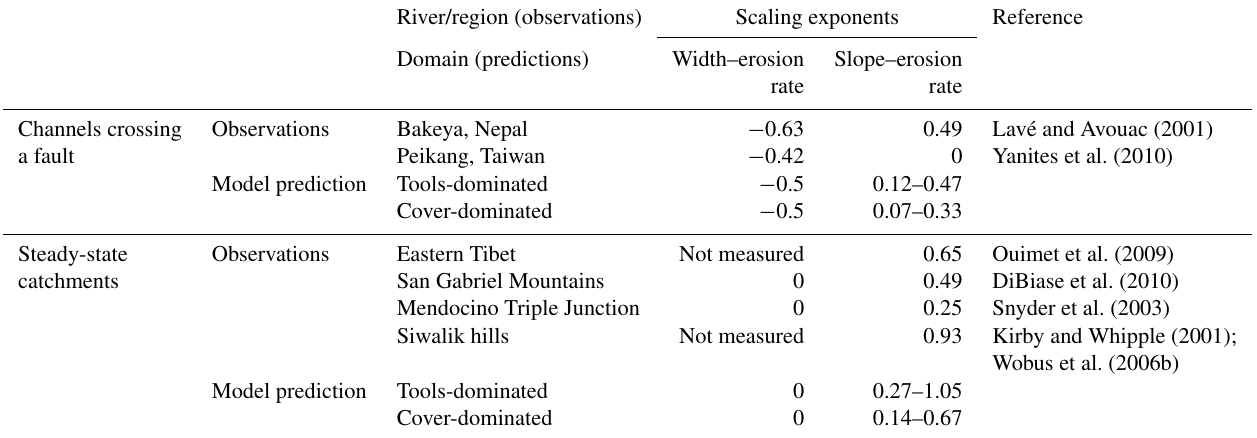
Table 1. Data sets and scaling exponents used for model evaluation, as reported by Lague